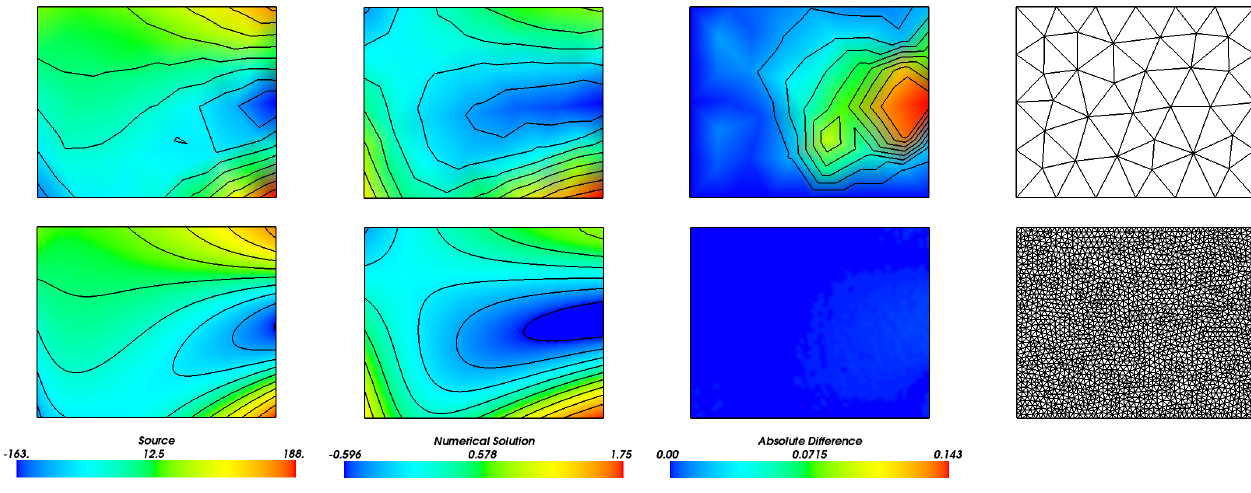
Fig. 3. From left to right: source term (Eq. 3) for the method of manufactured solutions advection-diffusion test case, the numerical solution calculated using a piecewise-linear Galerkin discretisation, the absolute difference between the analytical and numerical solutions, the meshes used to compute the previous images with average mesh spacings, h , of 0 . 08 (top) and 0 . 01